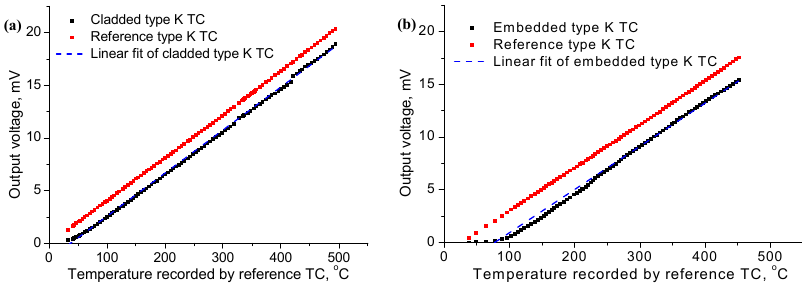
Figure 9. Voltage response of cladded type K thermocouple from ambient temperature to 450 °C ( a ) before and ( b ) after embedding.